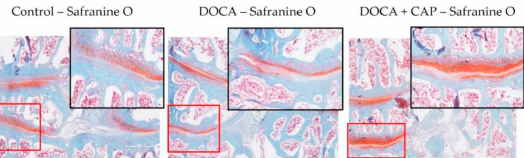
Figure A2. The results of Safranine O staining in cartilage in joints of the Control, DOCA, and DOCA + Captopril group, with the red box highlighting the regions exhibiting key differences in the staining